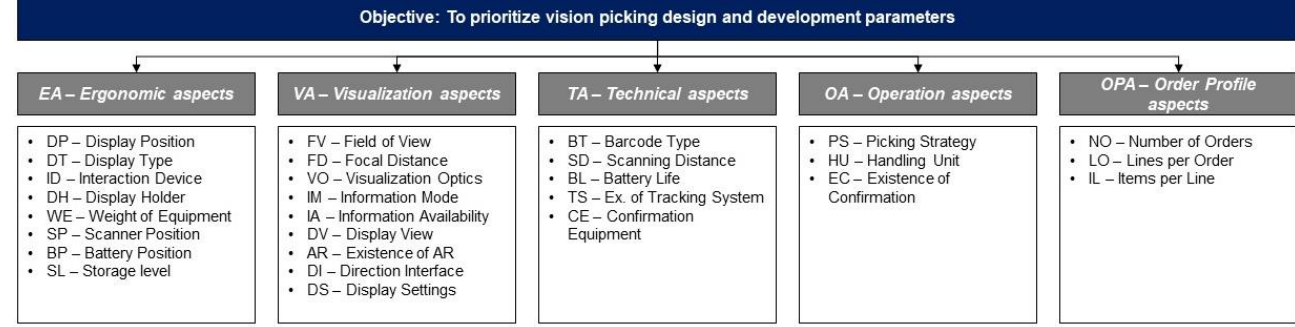
Figure 2. AHP-based hierarchical model to evaluate pick-by-vision design and development parameters.